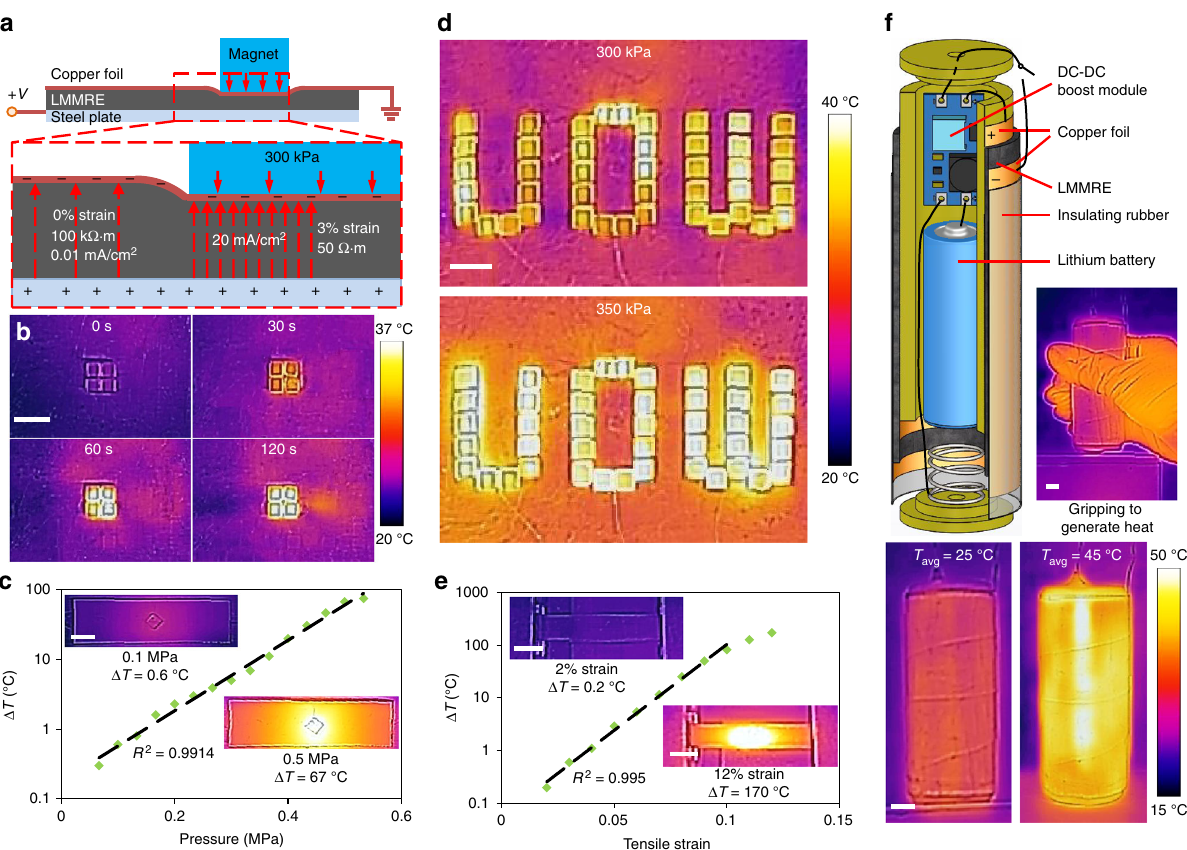
Fig. 5 Applications of the liquid metal- fi lled magnetorheological elastomer (LMMRE) in heating devices. a Operating principle of the pressure-sensitive heating device. b Temperature change on the fi lm at different times after applying magnets. c Temperature change vs pressure plot of the heating device. d Localised heating effect of the device. e Temperature change vs tensile strain plot. f Exploded schematics and thermal images of the hand-held heating column. Scale bars are 1